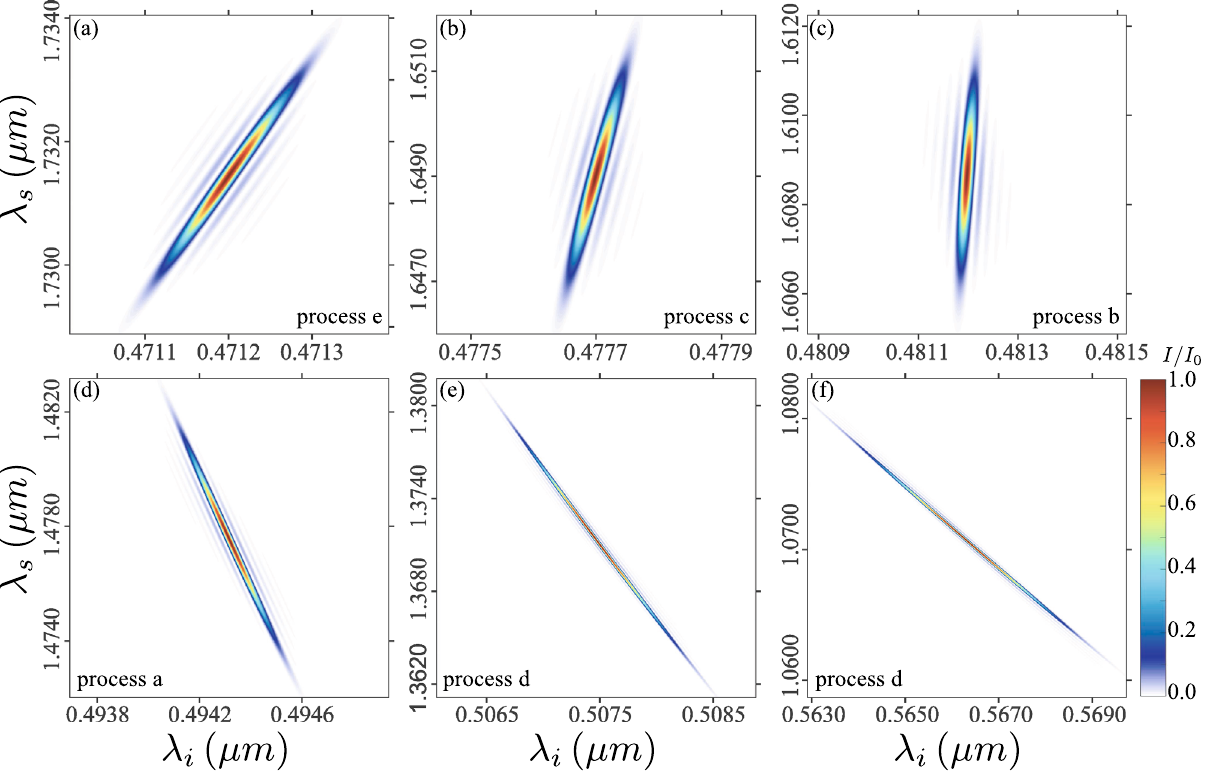
Figure 7. Normalized joint spectral intensity of the individual processes shown in Fig.